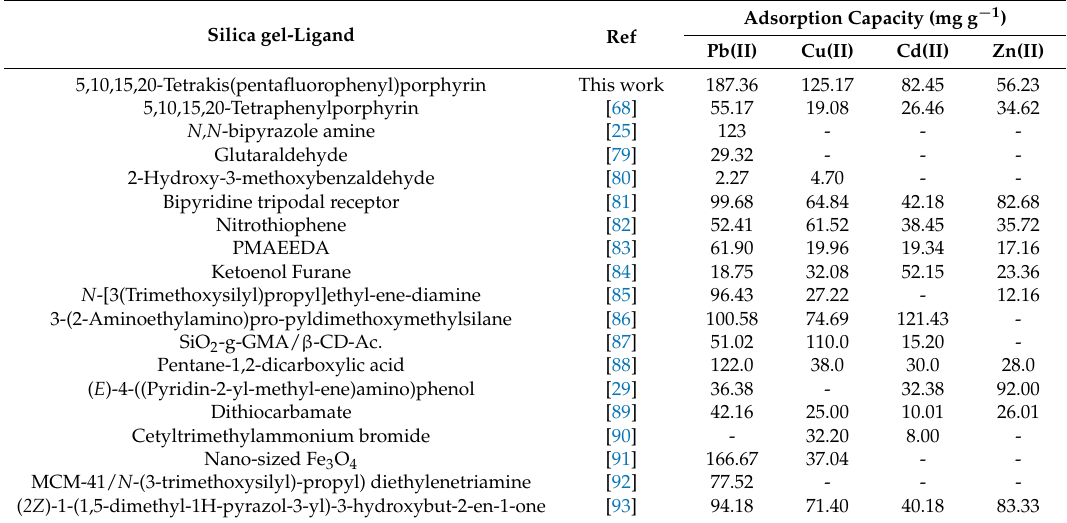
Table 7. Comparison of SiTF 5 PP performances with some recently reported sorbents for Pb(II)